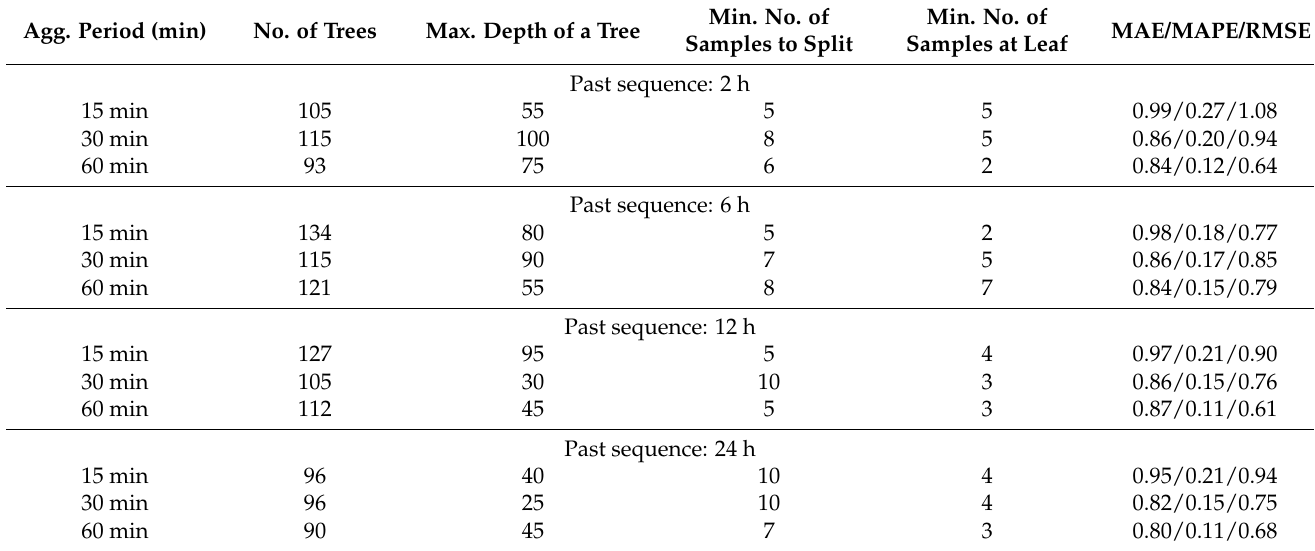
Table 2. Optimal random forest (RF) parameters after grid search with evaluation metrics. Agg. Period